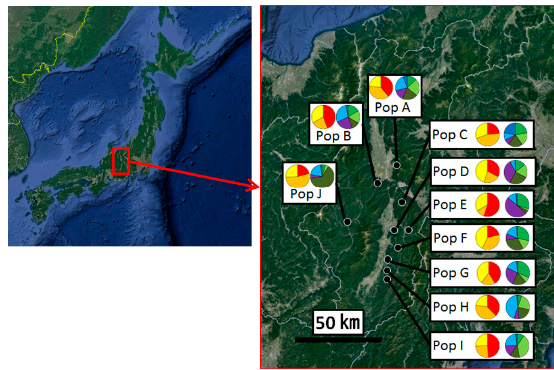
Figure 1. Locations of populations where matsutake mushrooms were collected in Nagano prefecture, Japan (black-filled circles) and the results of Bayesian clustering analyses for K = 3 and K = 6 (pie charts). The population names correspond with Table 1. The colors of each cluster correspond with Figure 3. Original maps were obtained from Google Earth. Pop: population.